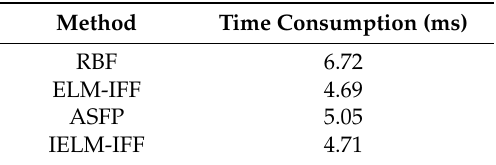
Table 11. Time consumption of different algorithms.